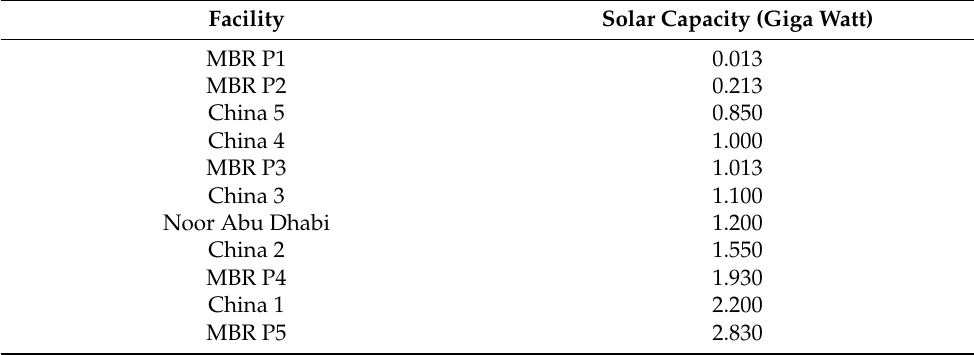
Table 3. Solar capacity of the eleven solar installations considered.